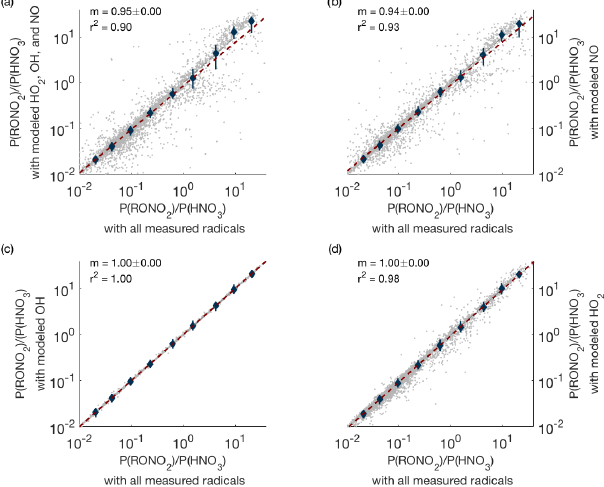
Figure A1. Comparison of P( RONO 2 )/P( HNO 3 ) when measured concentrations of all possible radicals are used ( x axis) versus when measured concentrations are replaced by modeled concentrations ( y axis). Panel (a) shows the result when modeled concentrations of OH, HO 2 , and NO are all used simultaneously; panels (b–d) show the effect of replacing measured with modeled values one species at a